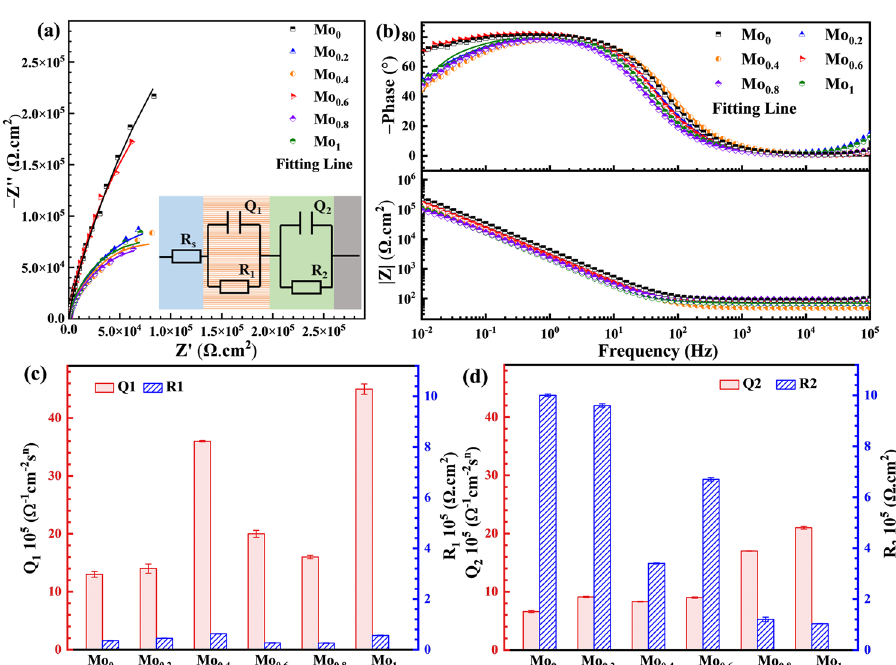
Fig. 5 EIS measurements in 5 mM H 2 SO 4 solution. a Nyquist plots, b Bode plots, c , d the variation of fi t resistance and capacitance, the standard deviations (error bars) of the three tests for Q 1 , Q 2 , R 1 , R 2 .